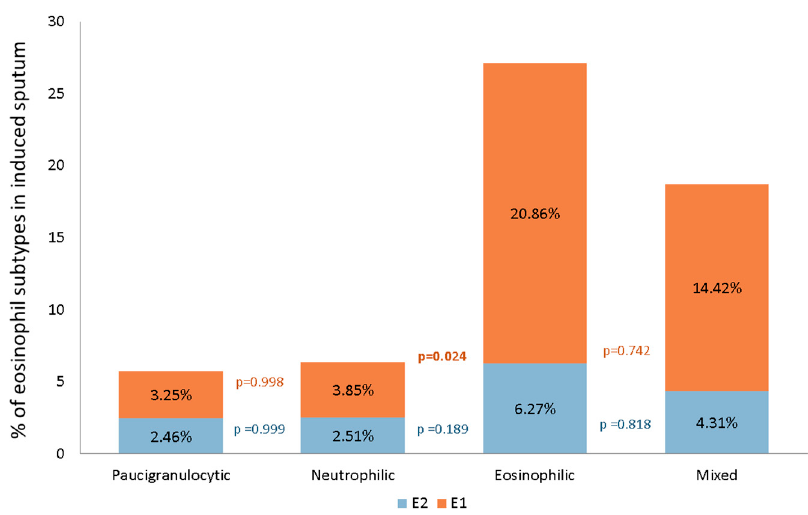
Figure 2. E1 and E2 distributions according to different bronchial inflammatory phenotypes. Table 2. Flow cytometry results: eosinophil populations, phenotypes, and cytokines in induced spu- tum supernatant.